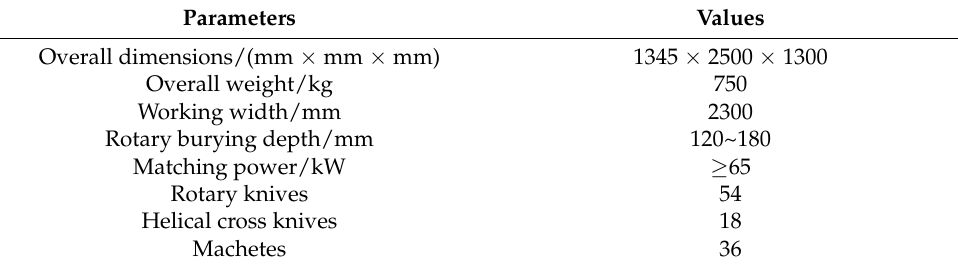
Table 1. The main structural parameters of a herringbone type rotary tiller.